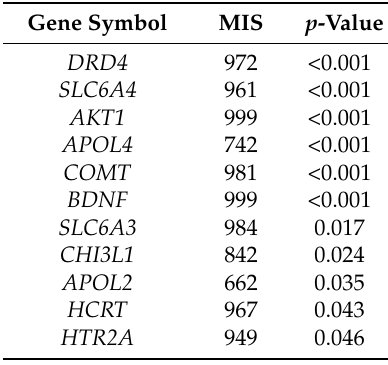
Table 4. Information on important disease genes of